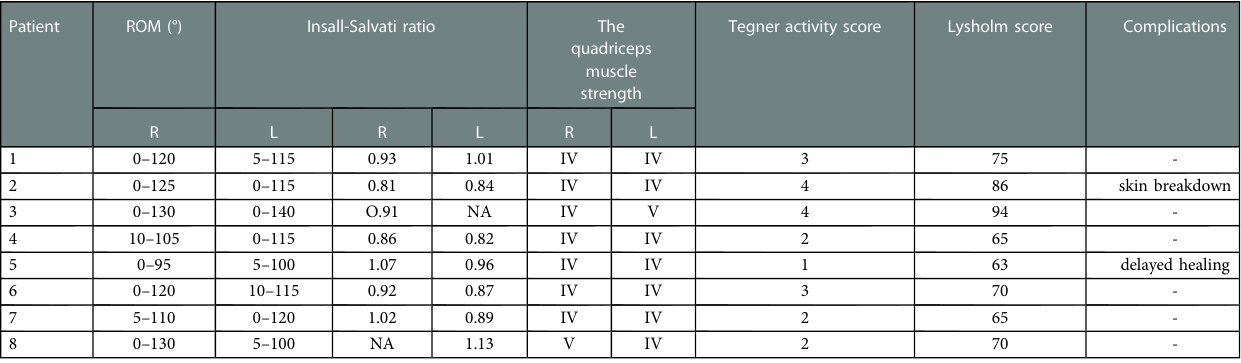
ROM, Range of motion; NA, not available.